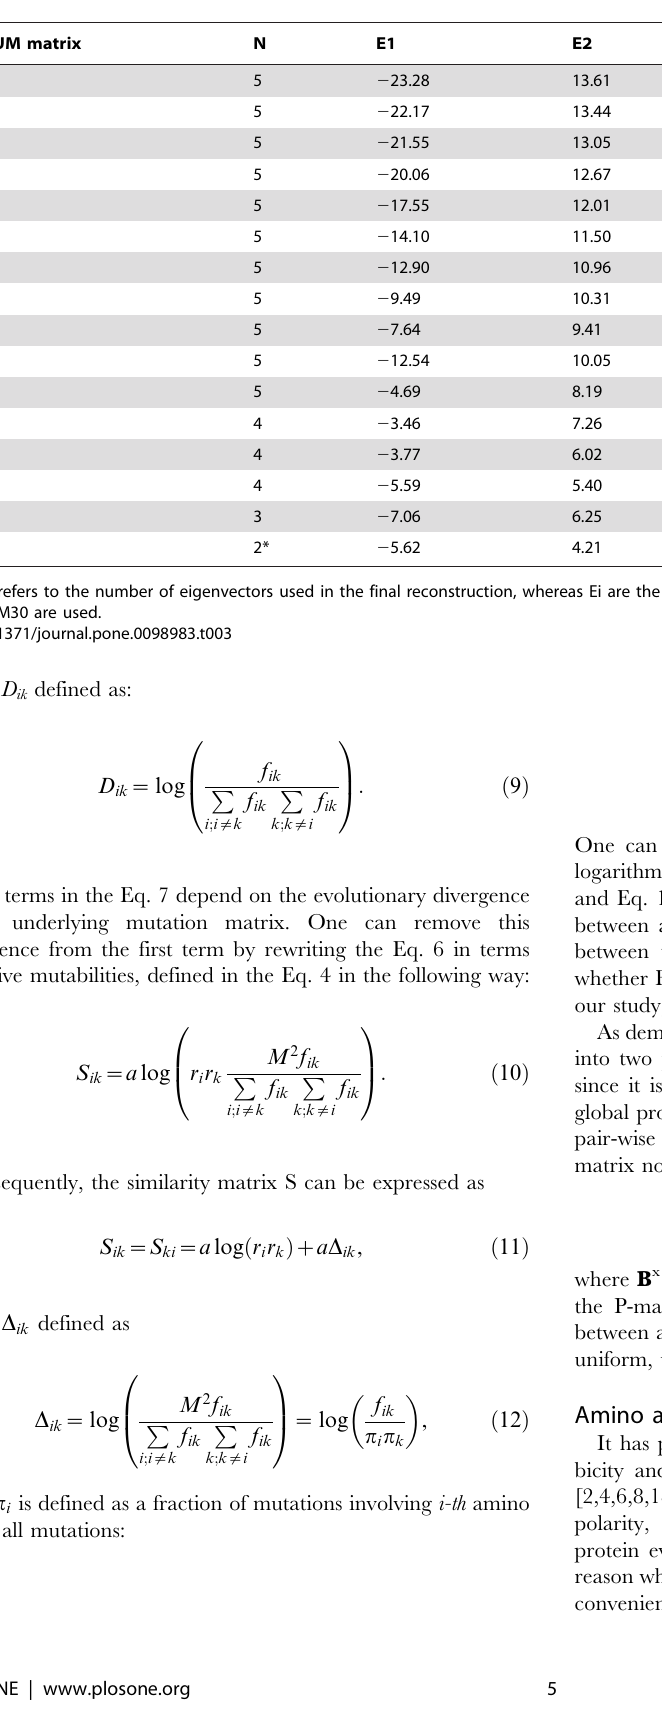
Table 3. Optimised coefficients for matrix reconstruction for final models.